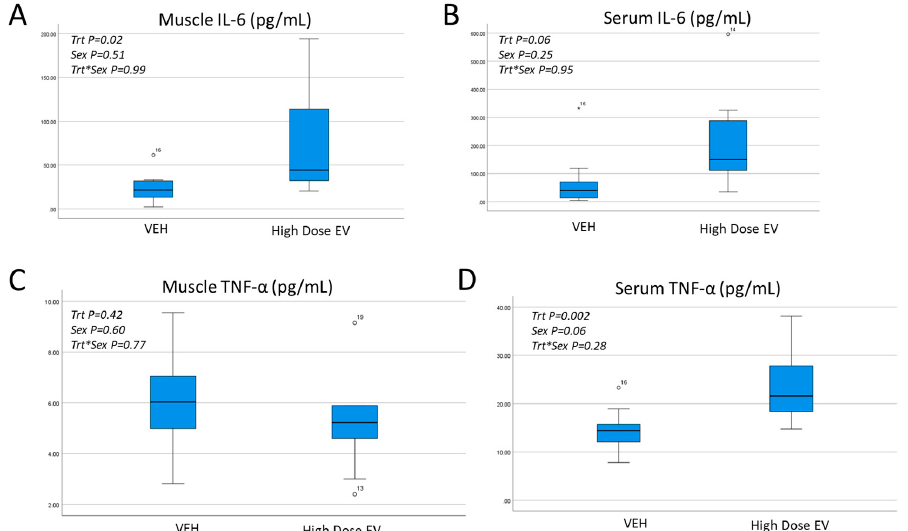
Figure 4. Effects of EV treatment on local and circulating inflammatory cytokines. Muscle-derived IL-6 ( A ) is increased significantly with EV treatment, which is associated with a trend toward higher serum IL-6 ( B ). Muscle-derived TNF-alpha ( C ) is not significantly increased with EV treatment, but serum TNF-alpha is significantly higher in EV-treated mice ( D ). Two-factor ANOVA was performed with treatment and sex as the two factors ( n = 5 male, 5 female per group). °,* represent outliers. 3.3. Effects of High Dose EV Treatment on Muscle Proteins Following Ischemia and Reperfusion Table 3. Proteins identified from functional enrichment (ToppFun) analysis of upregulated proteins (Table S2) in the EV-treated hindlimb related to acute inflammatory response and wound healing. Fold-change (FC) and p -values are shown for each